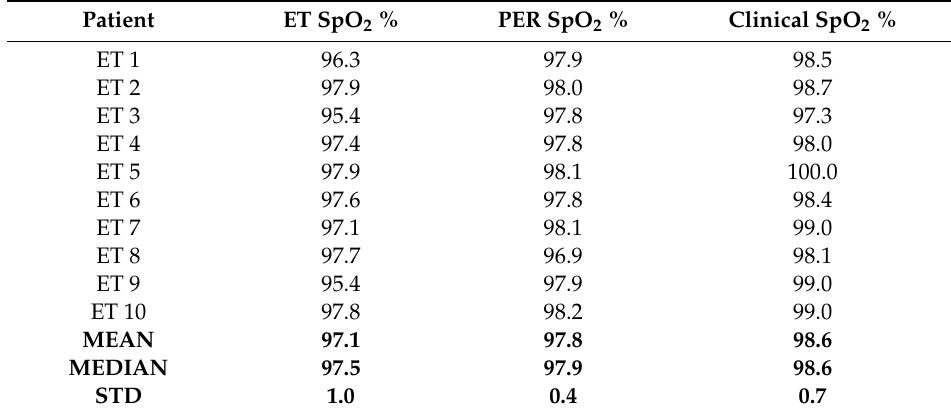
Table 1. The mean SpO 2 reading from each patient for the ET, PER and clinical sensors. Standard mean, median and standard deviation of the results is shown.